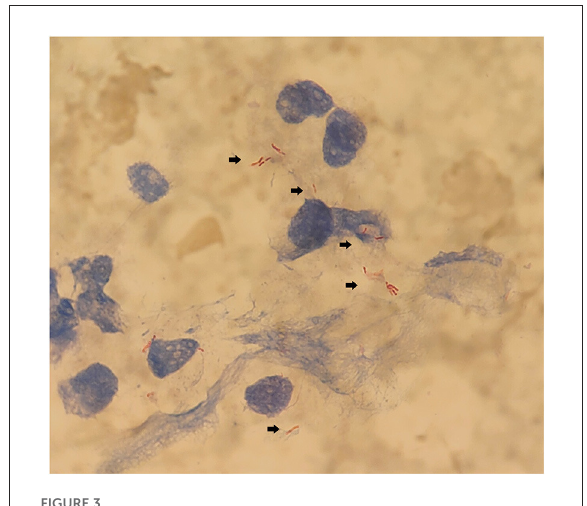
FIGURE3 Acid-fast bacilli are shown in the neonatal